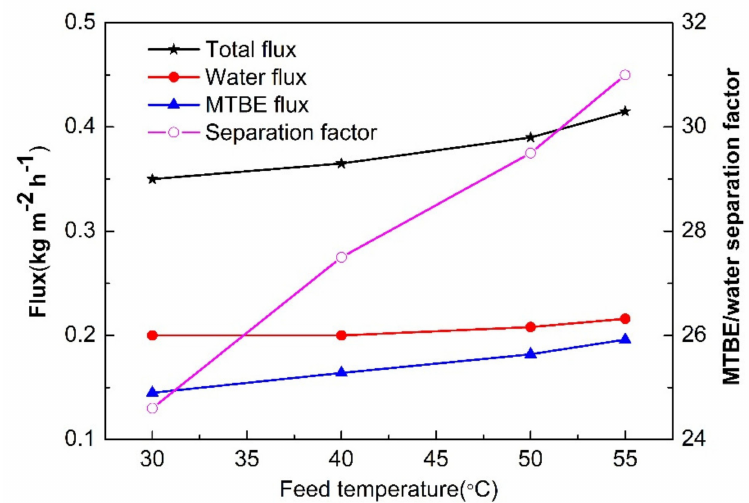
Figure 11. The feed temperature dependence of MTBE / water separation performance.